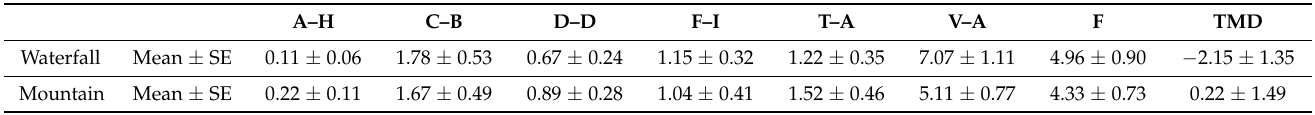
Table 1. POMS 2 scores after stimulation by viewing a waterfall image ( n = 27) and a mountain image ( n = 27, Jo et al., 2022 [9]) via a large, high-resolution